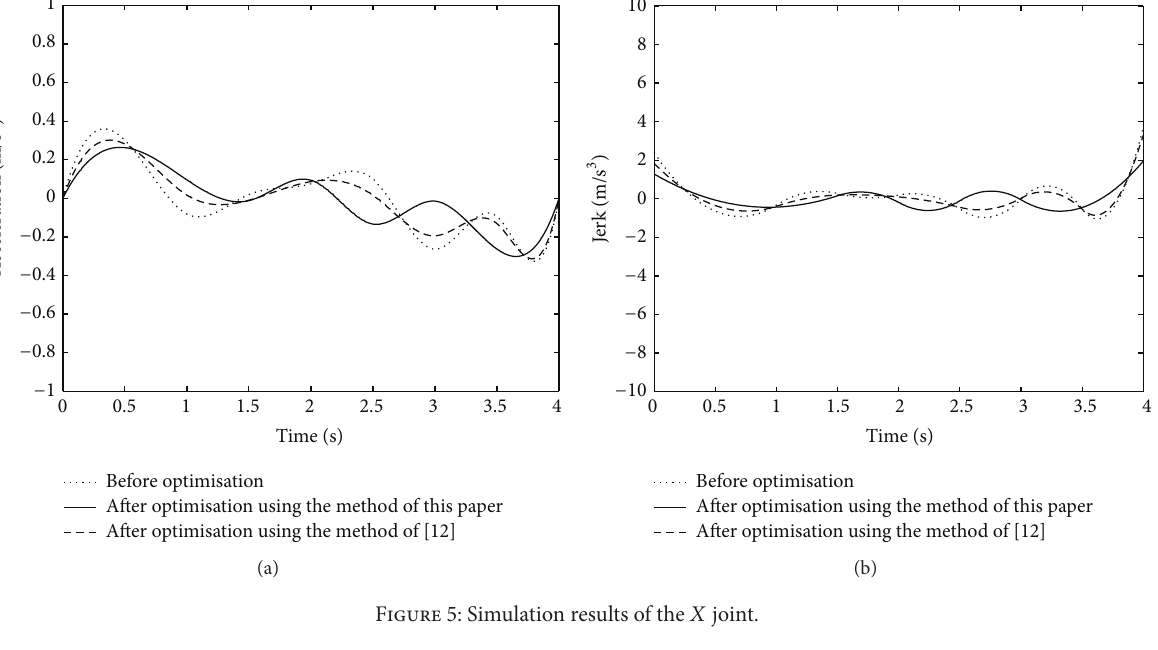
Figure 5: Simulation results of the 𝑋 joint.